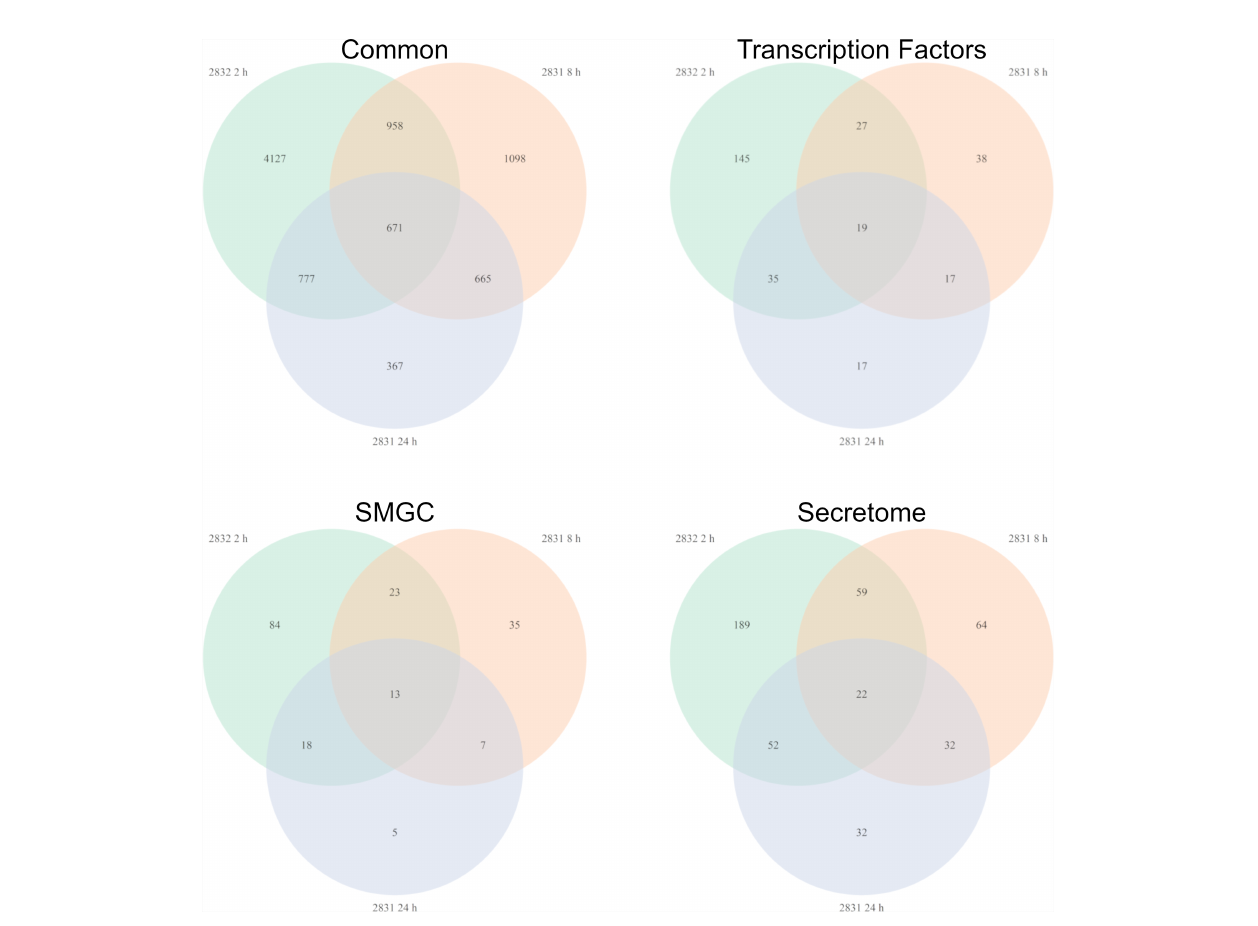
FIGURE 6 | Fusarium verticillioides genes expressed in response to Streptomyces strain s2831 that cause strong inhibition. The number of DEGs was highest at 2 h for the Fv- s2832 interaction and 8 and 24 h with strain s2831. Comparisons to fi nd similarly expressed genes were made and visualized by Venn Diagrams. Additional comparisons were made to parse gene encoding for transcription factors, secondary metabolite gene clusters, and secretome encoding